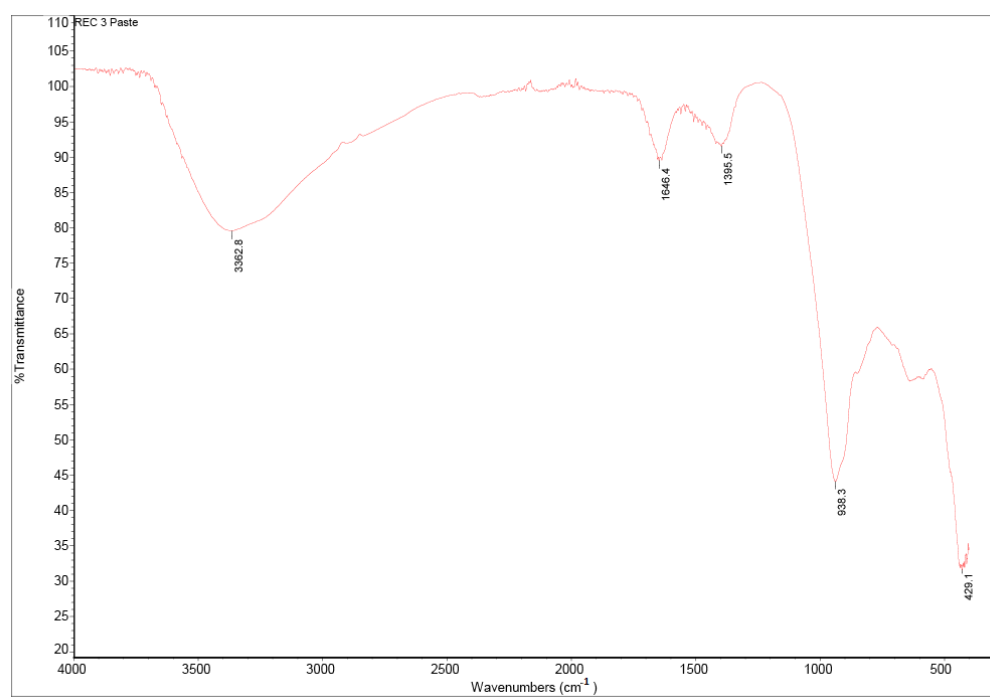
Figure 13. FTIR analysis for REC 3.